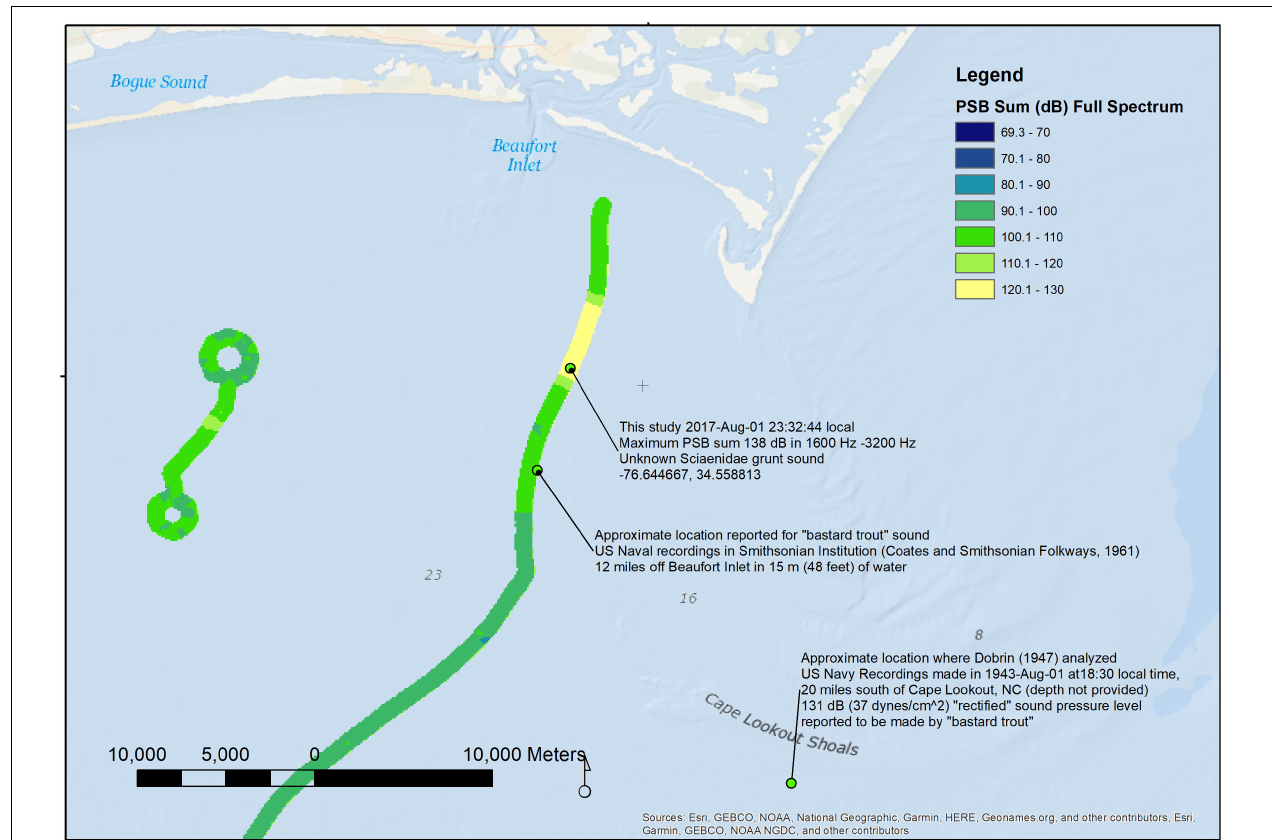
FIGURE 12 | A map of wave glider track August-01 through August-02 2017 near Cape Lookout, NC, United States for comparison with approximate locations of the United States Navy recordings of “bastard trout” analyzed by Dobrin (1947); the full-spectrum PSB sum (dB re 1 µ Pa 2 /Hz) has been overlaid on the